Question: Briefly state, in one sentence, what is plotted here.
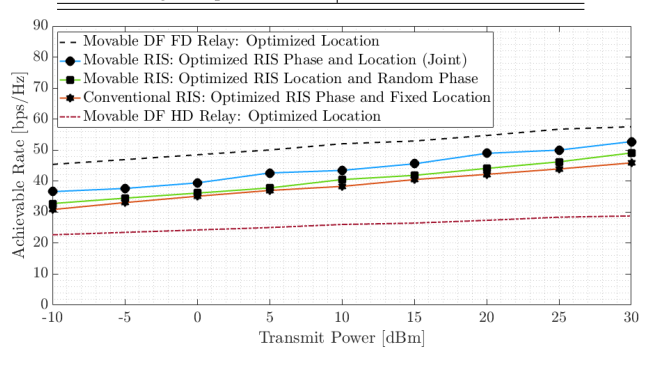
Answer: Achievable rate comparison of movable RIS and relay-aided AB-HPC systems under increasing PT .